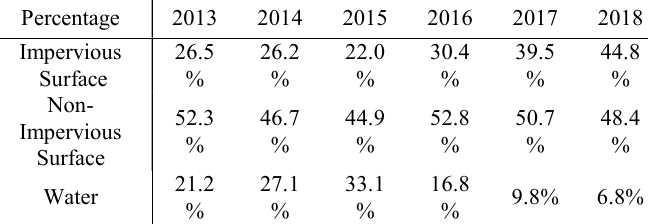
Figure 3. Variation of the spatial distribution of impervious surface in Hengqin new area from 2013 to 2018 As can be seen from the figure, the proportion of impervious surface in Hengqin area has increased year by year, from 26.5% in 2013 to 44.8% in 2018, an increase of 18.3%. Since the establishment of the Hengqin island in 2009 as a free trade zone, urbanization has developed rapidly. With the successive opening of the Hengqin Bridge and the Lotus Bridge, Hengqin island has been integrated with Zhuhai City and Macau, becoming the second land route to the mainland. Hengqin new area is the intersection of Guangzhu and Jiangzhu Expressway. These trunk lines will be connected to Macao through Hengqin new area, and the distribution of impervious surfaces will gradually expand.